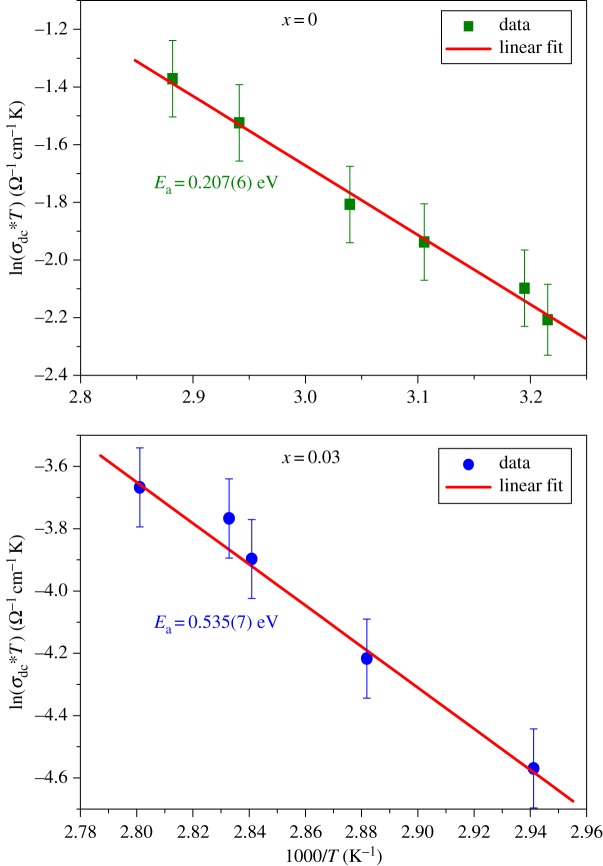
Variation of the ln(σdcT) versus 1000/T for La0.7−xDyxSr0.3MnO3(x = 0.00 and 0.03) compounds.